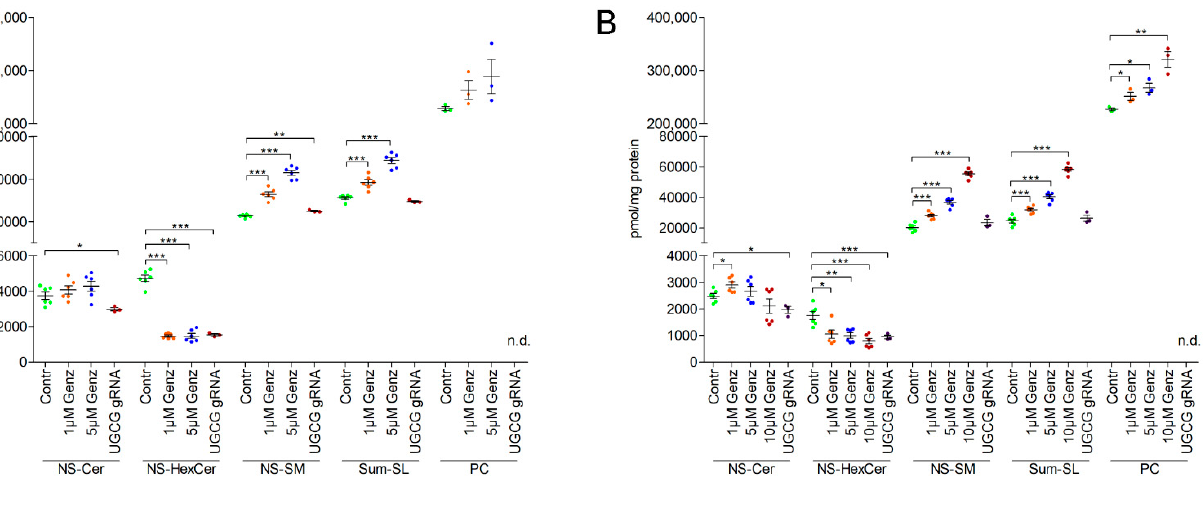
Figure 6. Genz treatment of Lovo and HCT116 cells lead to a concentration-dependent increase of sphingomyelin (SM). Lipids were quantified by C18-reversed phase UPLC/MS 2 in MRM mode using internal standards for each lipid class. Major sphingolipids containing non-hydroxy fatty acids (N) and (C18)-sphingosine (S) were recorded; Cer, ceramide,